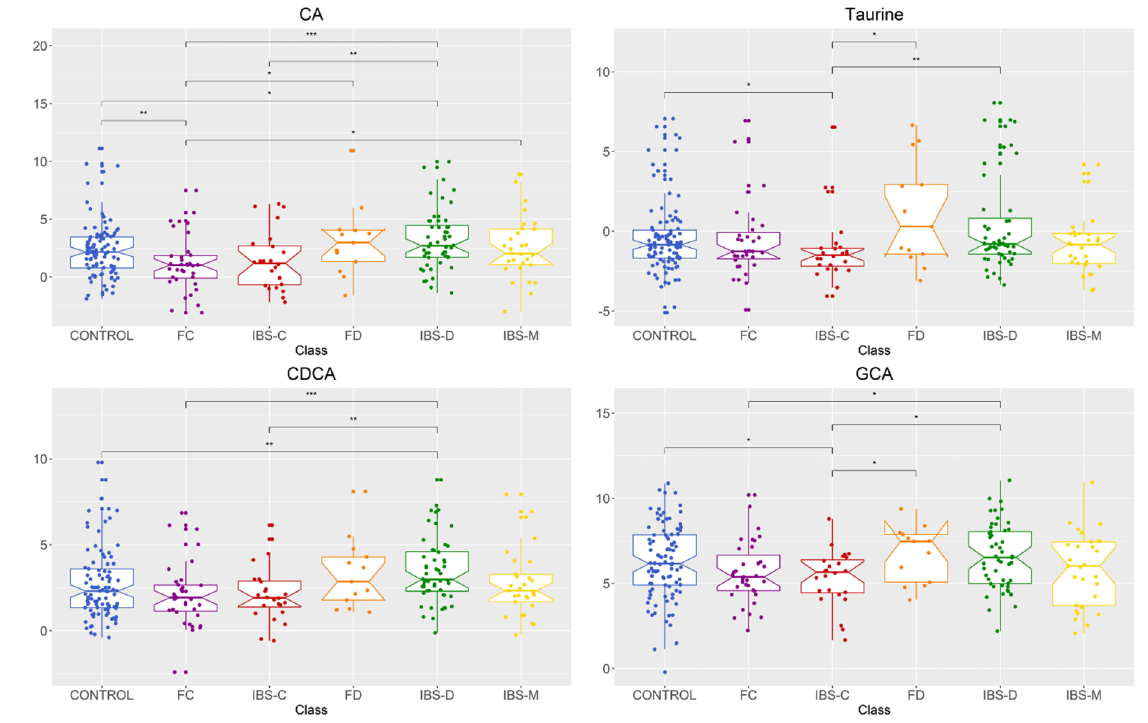
Figure 2. Bile acid metabolite distributions among healthy control, IBS subtypes, and functional gut disorders groups for metabolites with significantly different abundances between groups. Data presented as logged values of µg/mg of fecal dried weight. Healthy control (control), functional constipation (FC), IBS-constipation (IBS-C), functional diarrhea (FD), IBS-diarrhea (IBS-D), IBS-mixed (IBS-M). Boxplots show median (center line), 25th and 75th percentile (top and bottom of boxes, respectively), with whiskers representing 1.5 times the inter-quartile range, and boundaries of notches show 95% confidence interval (CI). Statistical significance denoted as p < 0.05 (*), p < 0.01 (**), p < 0.001 (***). Abbreviations: cholic acid (CA), chenodeoxycholic acid (CDCA), glycol-cholic acid (GCA).